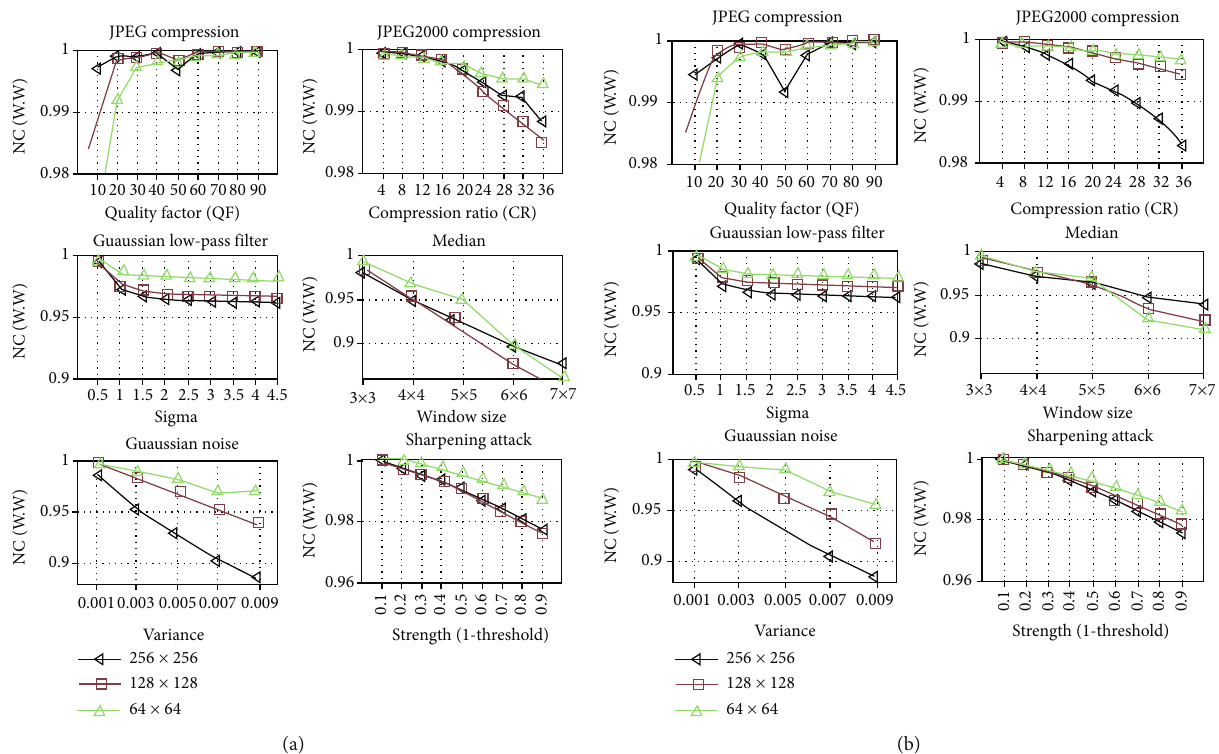
Figure 10: Parameters with di ff erent types of attacks with respect to NC values: (a) lion image and (b) Elaine